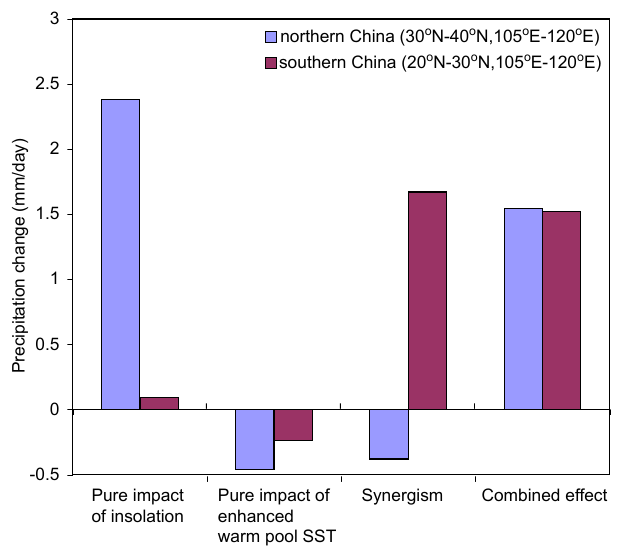
Figure 3. Summer precipitation change averaged over northern and southern